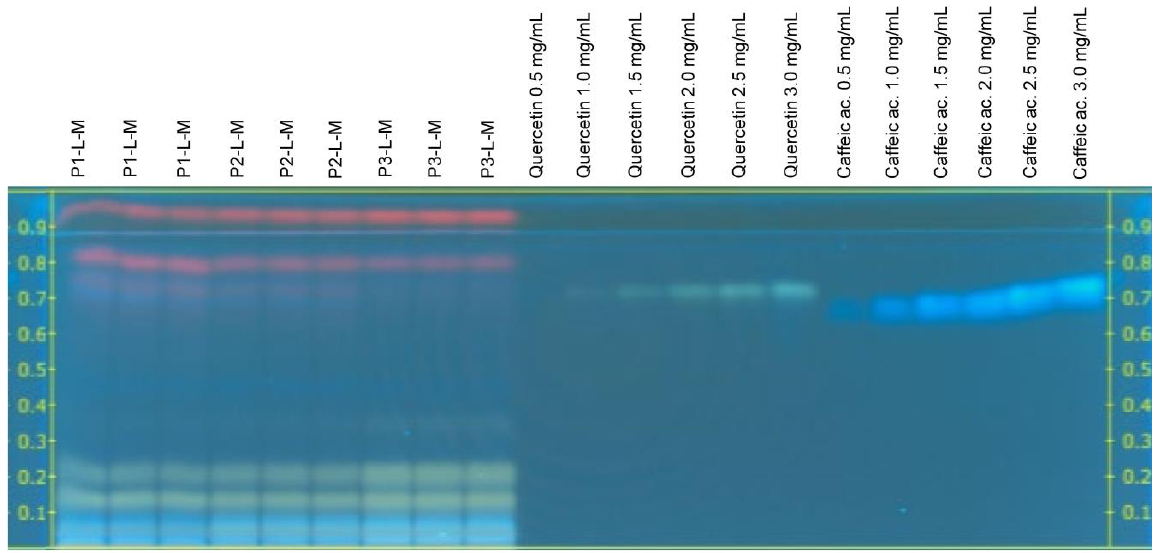
Figure 1. HPTLC chromatogram of methanolic extracts from leaves of Cosmos sulphureus under visible light in the transmittance mode developed using ethyl acetate (100): formic acid (11): acetic acid (11): water (26) ( v / v / v / v ) as the mobile phase after derivatization with 1% 2-aminoethyl diphenyl borate ( w / v ).